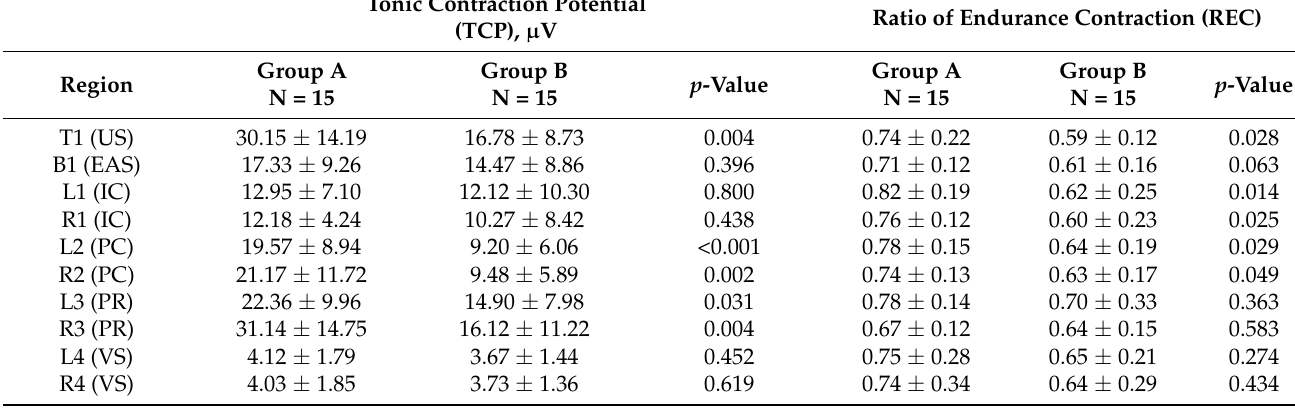
Table 3. Type-I muscle function assessment results of participants, postpartum and asymptomatic, control (Group A), PSUI participants (Group